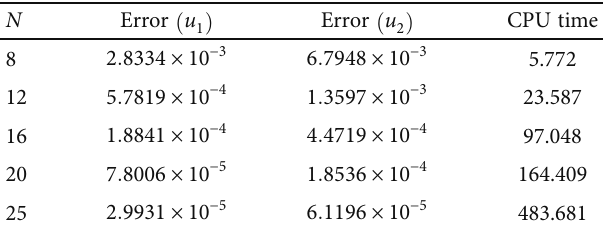
= 0 : 85,0 : 90,0 : 95,1, i = 1, 2, 3 for N = 9 in : ν i i Table 5: Maximum absolute errors obtained by SSKCP collocation method for di ff erent values of N in Example 3.